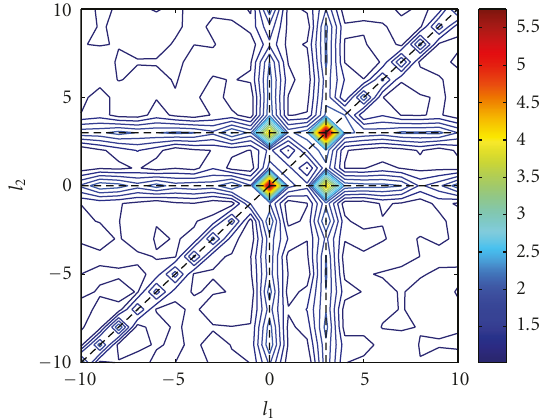
Figure 4: Noise variance at the output of the RD-CTCF estimator as a function of the lag parameters l 1 and l 2 for the cycle frequency 0. The values of l 0 and l 3 have been fixed to 0 and 3, respectively. The system parameters are: 1MHz symbol frequency, 10 MHz sample = 10. The number of noise realizations is frequency, σ 2 n